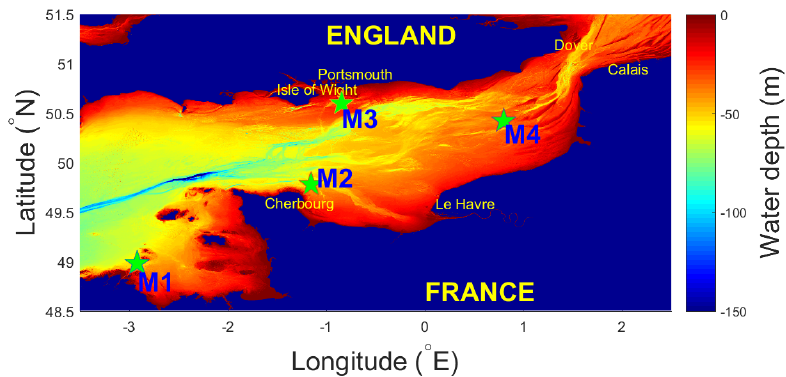
Figure 2. Study area map: four stations M1, M2, M3 and M4 are marked as green stars. The color bar indicates the bathymetric depth [35].